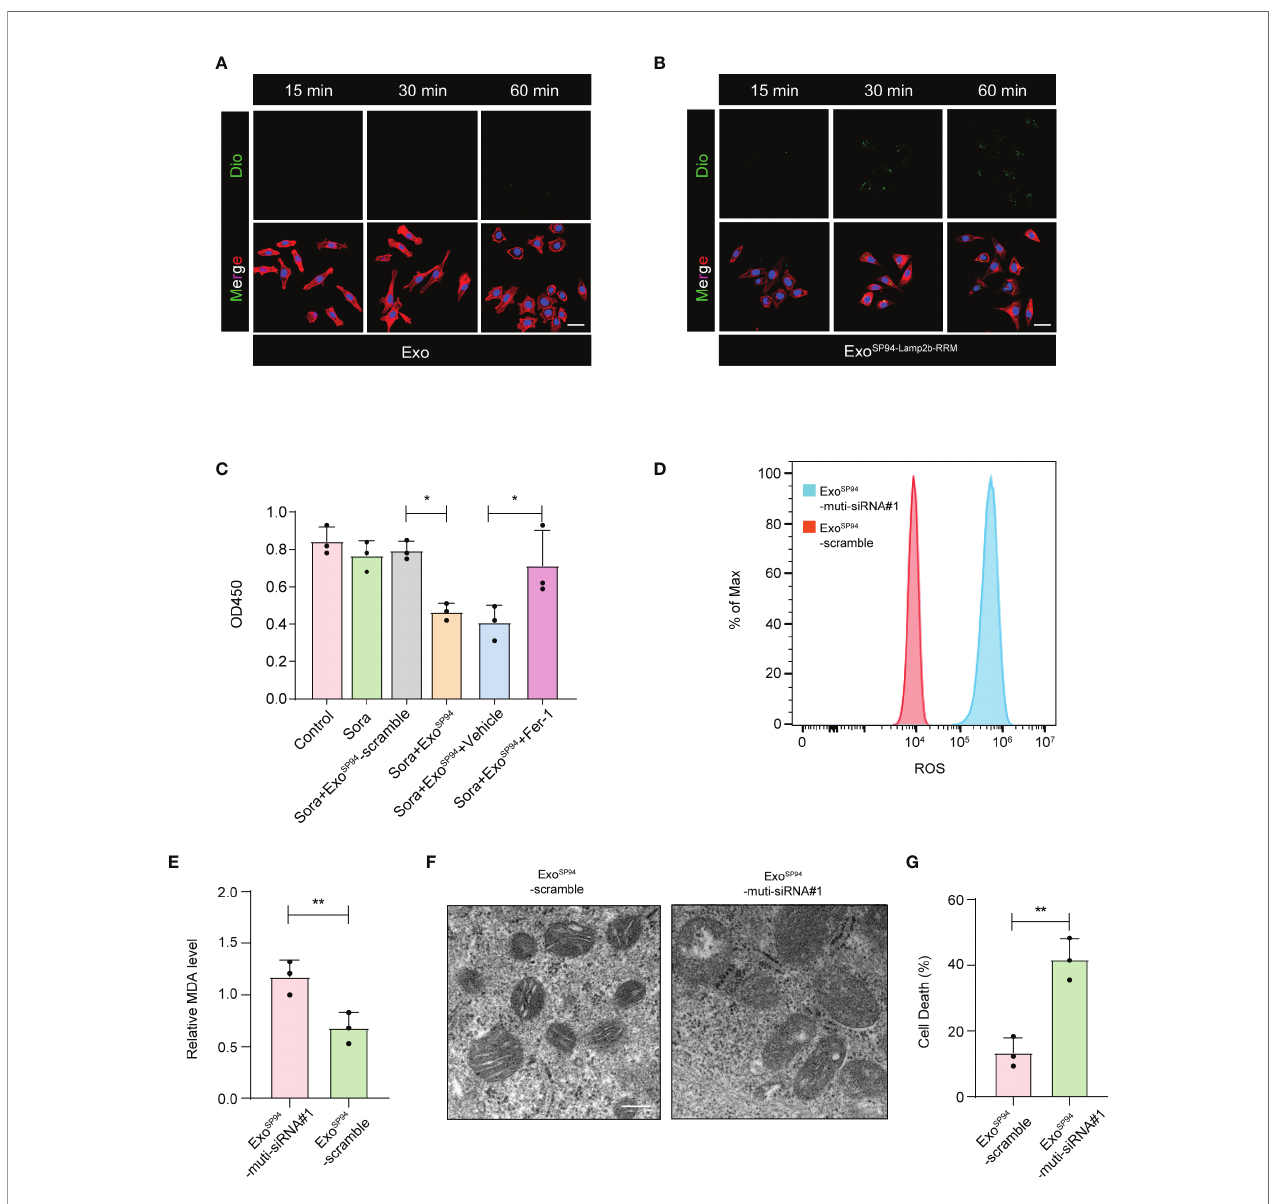
FIGURE 5 | SP94-Lamp2b-RRM-functionalized exosomes could overcome sorafenib resistance by enhancing sorafenib-induced ferroptosis in HCC cells. (A – B) Dio labeled engineered exosomes or control exosomes were incubated with HCC cells for 15, 30 or 60 min at 37°C. Then unbound exosomes were removed by PBS washing. Exosome endocytosis was analyzed by confocal microscopy. The nuclei and F-actin were counterstained with DAPI (blue) and TRITC phalloidin (red), respectively, (scale bar, 50 µm). (C) Sorafenib-resistant HepG-2 cells treated with sorafenib and SP94-Lamp2b-RRM-functionalized exosomes containing scramble or multi-siRNA#1. Viability of sorafenib-resistant HepG-2 cells as measured by the CCK-8 assay. (D) Sorafenib-resistant HepG-2 cells were treated with sorafenib in combination with SP94-Lamp2b-RRM-functionalized exosomes containing scramble or multi-siRNA#1, and the ROS production was assessed by DCFH-DA staining followed by fl ow cytometry. (E) MDA levels of sorafenib-resistant HepG-2 cells treated with sorafenib and SP94-Lamp2b-RRM-functionalized exosomes containing scramble or multi-siRNA#1. (F) TEM images of mitochondria in sorafenib-resistant HepG-2 cells cotreated with sorafenib and SP94-Lamp2b-RRM-functionalized exosomes containing scramble or multi-siRNA#1. (G) Sorafenib-resistant HepG-2 cells were treated with sorafenib and SP94-Lamp2b-RRM-functionalized exosomes containing scramble or multi-siRNA#1. Cell death was determined by PI staining coupled with fl ow cytometry. (C, E, G) The data are shown as the means ± S.E.M. (C) ANOVA with Dunnett ’ s t -test. (E, G) Unpaired t -test. * p < 0.05, ** p <